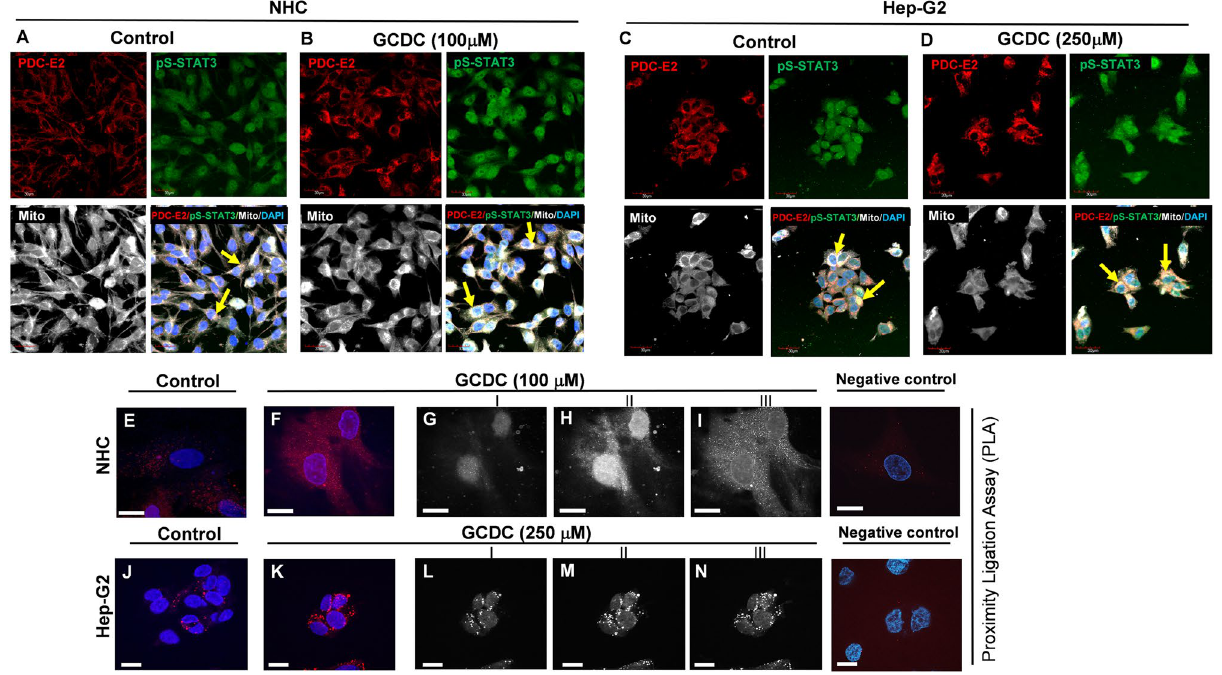
Figure 4. The presence of PDC-E2—p-STAT3 complexes in human cholangiocytes (NHC) and hepatocytes (Hep-G2). Human cholangiocytes (NHC) and hepatocytes (Hep-G2) were incubated with 100 or 250 µM of GCDC, respectively. In order to show mitochondrial localization of PDC-E2/pS-STAT3 complexes cells were incubated with 500 nM of MitoTracker. Immunofluorescence analysis revealed co-localization of PDC-E2 and p-STAT3 (S727) with MitoTracker in NHC ( A and B ) and Hep-G2 cells ( C and D ) (yellow arrows). Objective magnification ×20, zoom 3. PLA in situ hybridization assay was conducted using primary antibodies against PDC-E2 and p-STAT3 (Y705). PLA signals (red dots) indicate for the interaction between PDC-E2 and p-STAT3 in both NHC ( E and F ) and HepG2 ( J and K ) cells. Nuclear ( G and H ) and cytoplasmic ( I ) localization of PDC-E2-pY-STAT3 complexes in NHC cells and cytosolic localization of PDC-E2-pY-STAT3 complexes in Hep-G2 cells ( L–N ) are shown using three different z-stack. Scale bar is 30 µm. Nuclei were counterstained with DAPI. This experiment was repeated two times on independent batches of